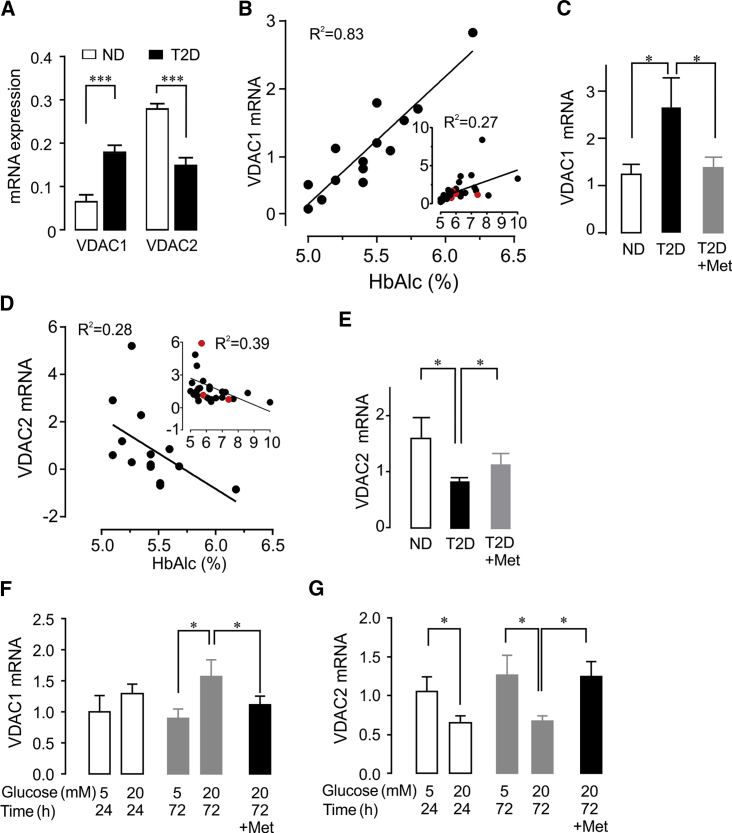
Expression of VDAC1 and VDAC2 in Human Pancreatic Islets(A) VDAC1 and VDAC2 mRNA levels in islets from non-diabetic (ND) and T2D donors. Mean ± SEM of 19 ND and 18 T2D.(B) Positive correlation between islet VDAC1 mRNA and donor HbA1c in ND (HbA1c < 6.0%) (n = 15; R2 = 0.83, p < 0.005); insert, correlation for ND + T2D, n = 30 including the four metformin-treated (red dots), R2 = 0.27; p < 0.05.(C) VDAC1 expression in islets from ND (n = 15), all T2D (n = 15), and four of these T2D with documented metformin therapy.(D) Negative correlation between islet VDAC2 mRNA and donor HbA1c in ND (n = 14; R2 = 0.28; p < 0.05). Correlation for ND + T2D: n = 30 including the four metformin-treated (red dots), R2 = 0.39; p < 0.05 (insert).(E) VDAC2 expression in islets from ND (n = 14), all T2D (n = 15), and four of these T2D with documented metformin therapy.(F and G) Glucotoxic condition (20 mM culture, 24 and 72 hr) mimics the T2D profile of VDAC1 expression in human islets. Metformin (20 μM) prevents the VDAC1 induction at 72 hr (F) and VDAC2 suppression (G) (n = 3–5 donors).